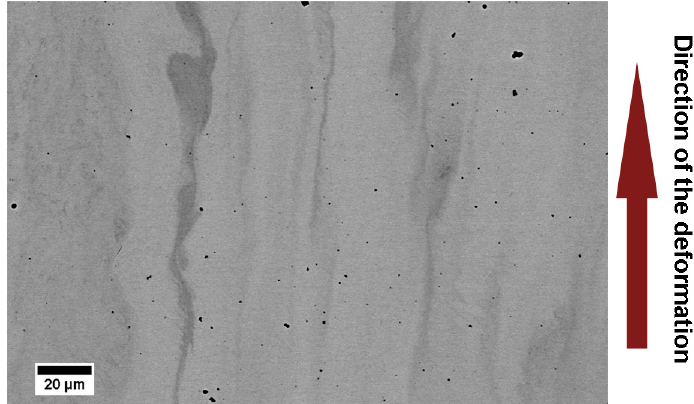
Figure 3. SEM–BSE micrograph of Ti15Mo alloy after high-pressure torsion (HPT) processing. Surface of HPT disk with highlighted direction of deformation (azimuthal direction). Darker and brighter areas are caused by the difference in chemical composition (black dots are polishing artefacts).